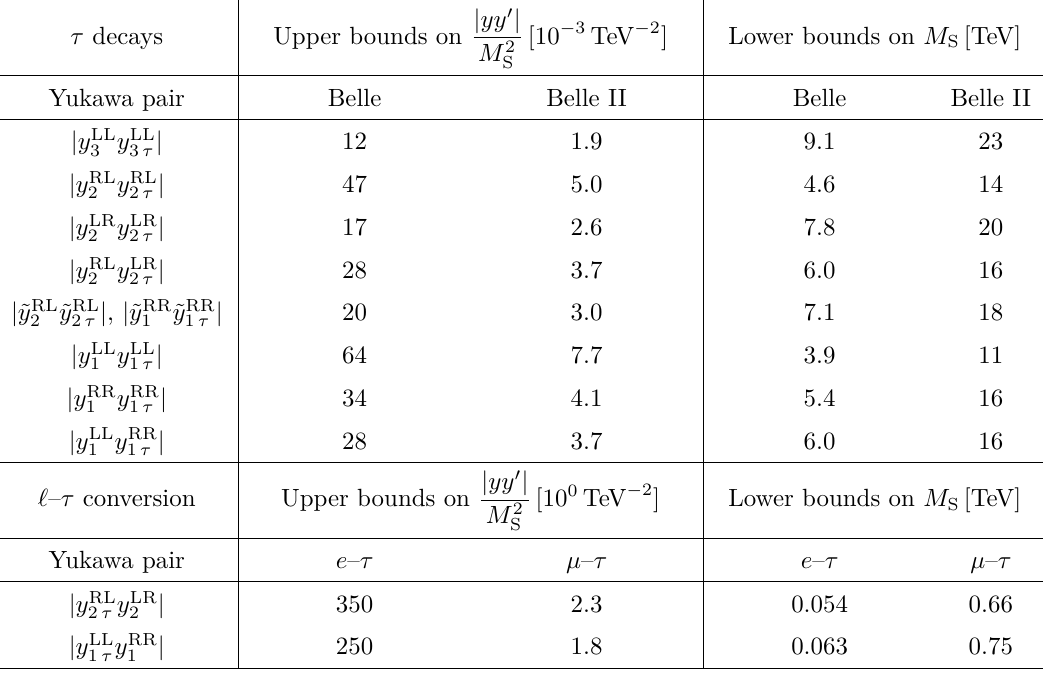
Table 4. Obtained bounds for the scalar leptoquark case from our results in ref. [1]. In the left-hand part of the table, we present upper bounds on the ratio | yy 0 | /M 2 course, also correspond to (with appropriate power of 10) upper bounds on the Yukawa pairs | yy 0 | , assuming M S = 1 TeV. On the right, there are lower bounds on the probed energy scale of the scalar leptoquarks mediating CLFV phenomena ( Λ strongest bounds found are shown, most of which are stemming from the τ decays analysis (Belle and Belle II results), the exception being the last couple of rows dedicated to Yukawas contributing only to ‘ – τ conversion. The values are given at the 99.8 % confidence